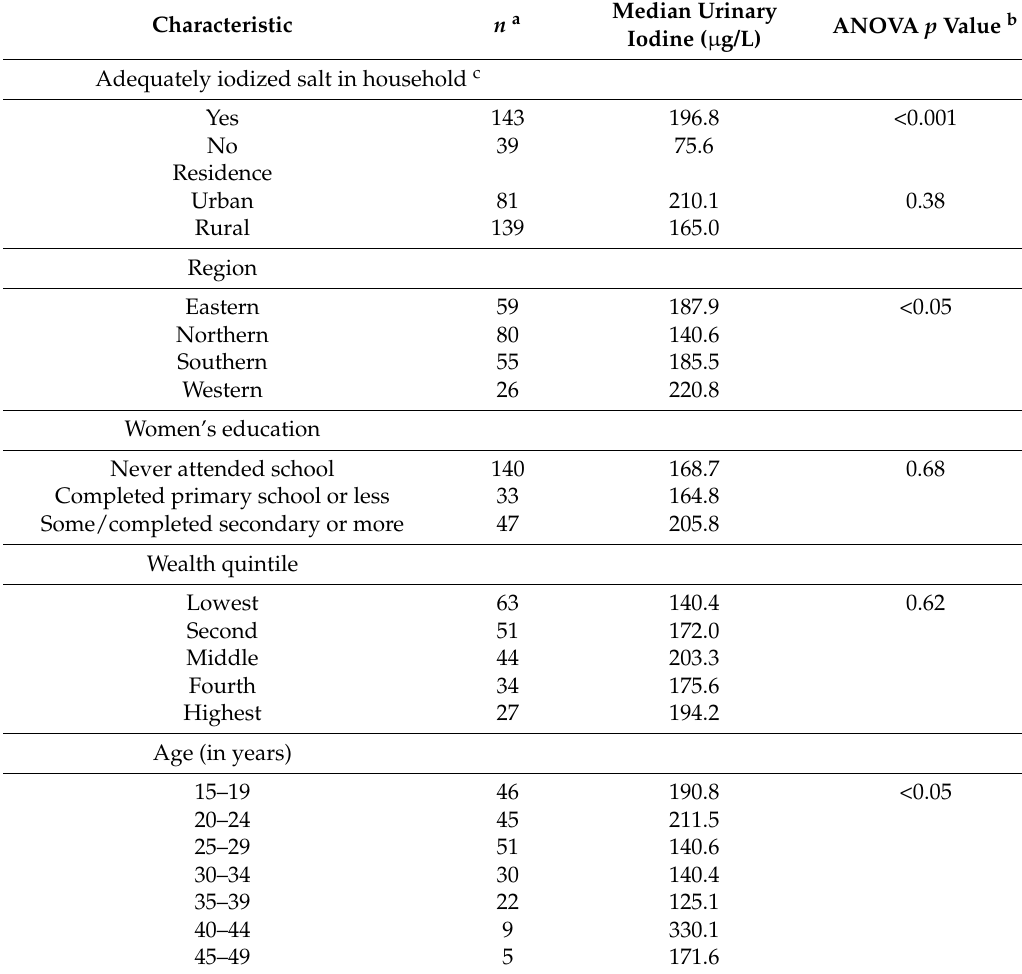
Table 4. Weighted geometric mean urinary iodine in non-pregnant lactating women 15–49 years, Sierra Leone